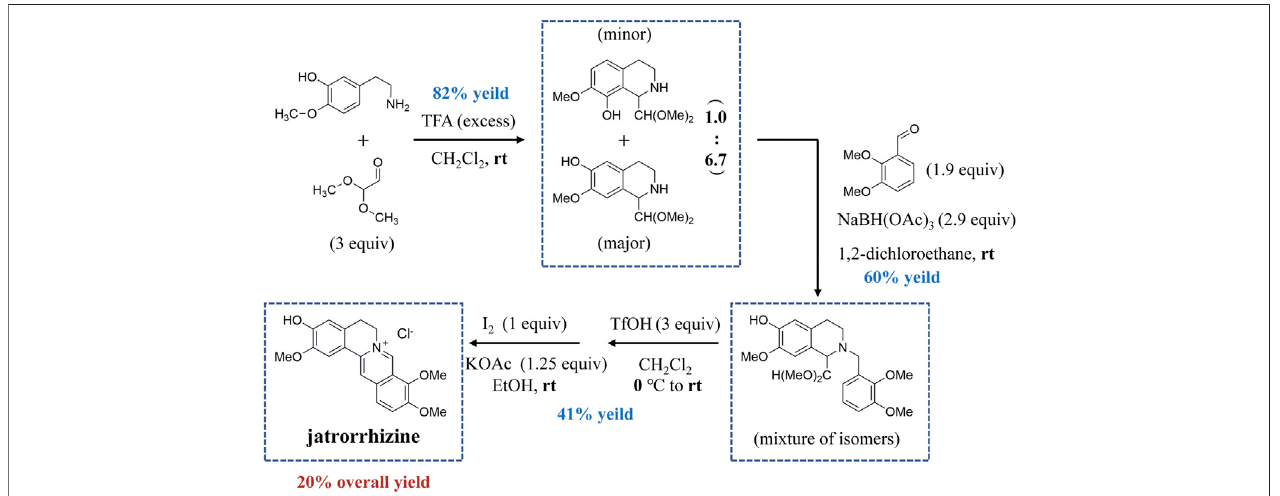
FIGURE 2 | The total syntheses of jatrorrhizine based on a uni fi ed